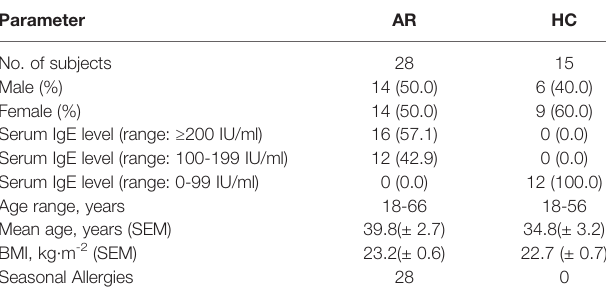
TABLE 1 | Clinical characteristics of the enrolled